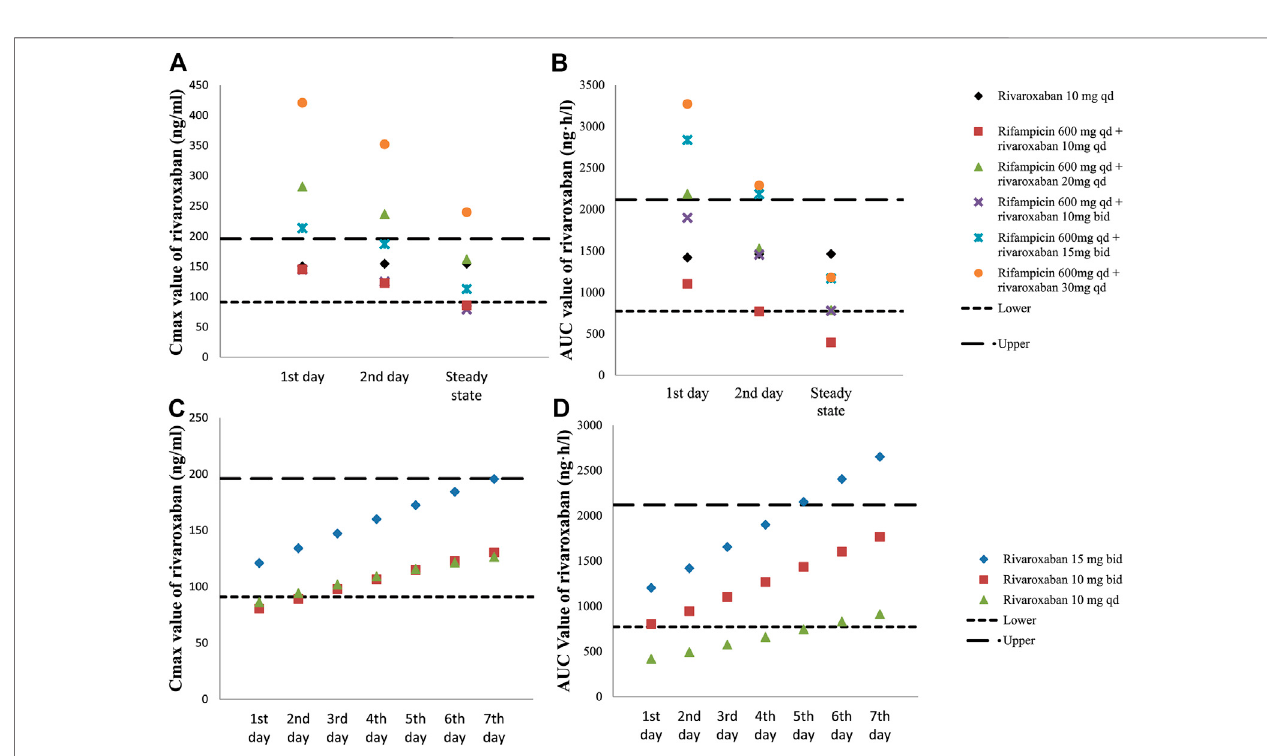
FIGURE 3 | Simulated exposure of rivaroxaban with or without rifampin. C max (A) and AUC (B) values on the fi rst day, second day and steady state in different dosing regimens of rivaroxaban-rifampin co-medication. C max (C) and AUC (D) values from the fi rst day to the 7th day after withdrawal of rifampin in different dosing regimens.